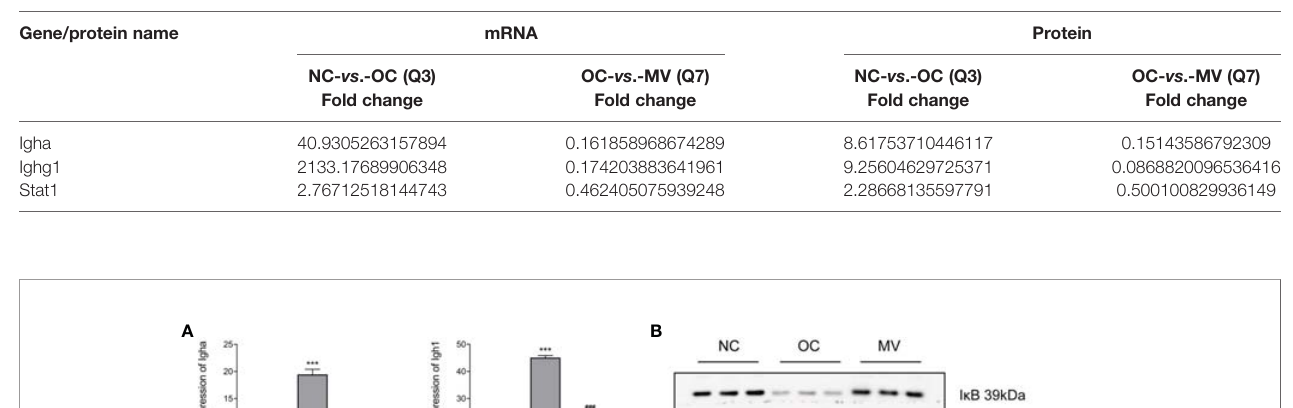
TABLE 3 | Expression of differentially expressed genes and differentially expressed proteins with the same trend for proteome and transcriptome in the comparison of NC- vs .-OC and OC- vs .-MV.